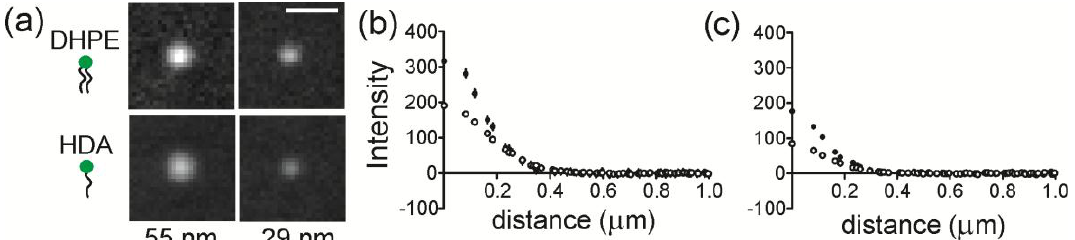
Figure 3. Location-guided colocalization measurements of fluorescent lipids at regions of membrane curvature. ( a ) cropped and averaged images for each size and lipid measured. All images have background subtracted and are scaled identically. Scale bar = 1.0 µm; ( b ) a radial plot of Fl-DHPE (black circles) and Fl-HDA (white circles) at regions with 55 nm radius of curvature; ( c ) a radial plot of Fl-DHPE (black circles) and Fl-HDA (white circles) at regions with 28 nm radius of curvature. The error bars represent the standard error of the mean (SEM).